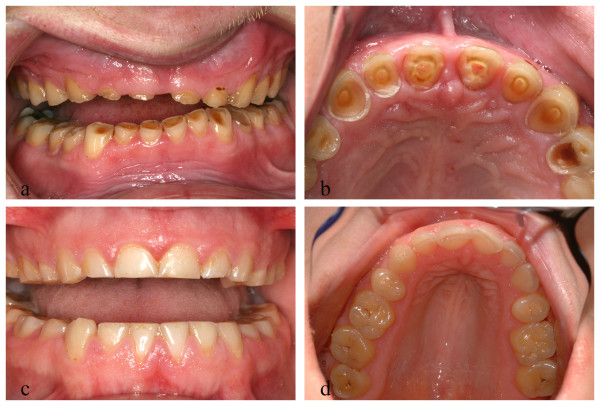
Tooth wear in PWS. (a, b) Extreme tooth wear with pulp exposure in 6 teeth in a 36-year-old male, (c, d) Typical tooth wear in a 28-year-old female.